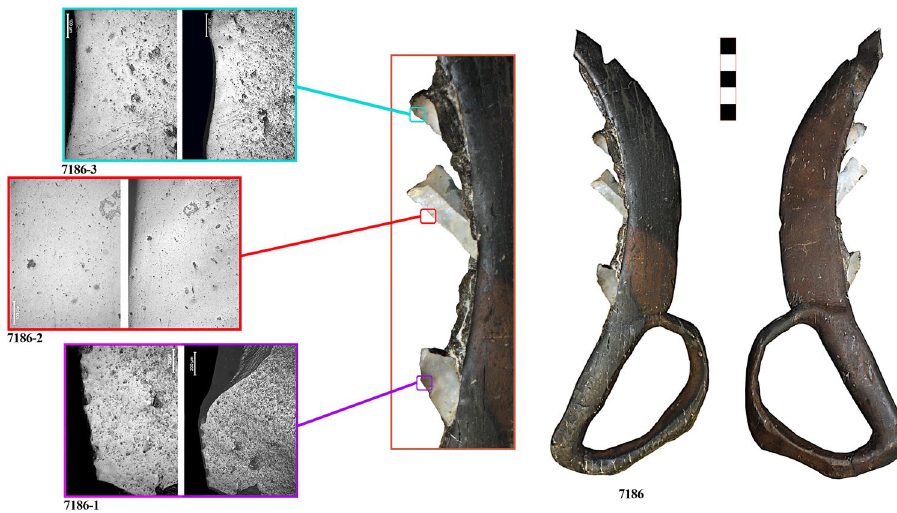
Figure 3. Sickle No. 7186 with macro and microscopic view of the lithic inserts (7186-1 to 7186-3). Micrographs have been taken at both 100 × and 200 × for each